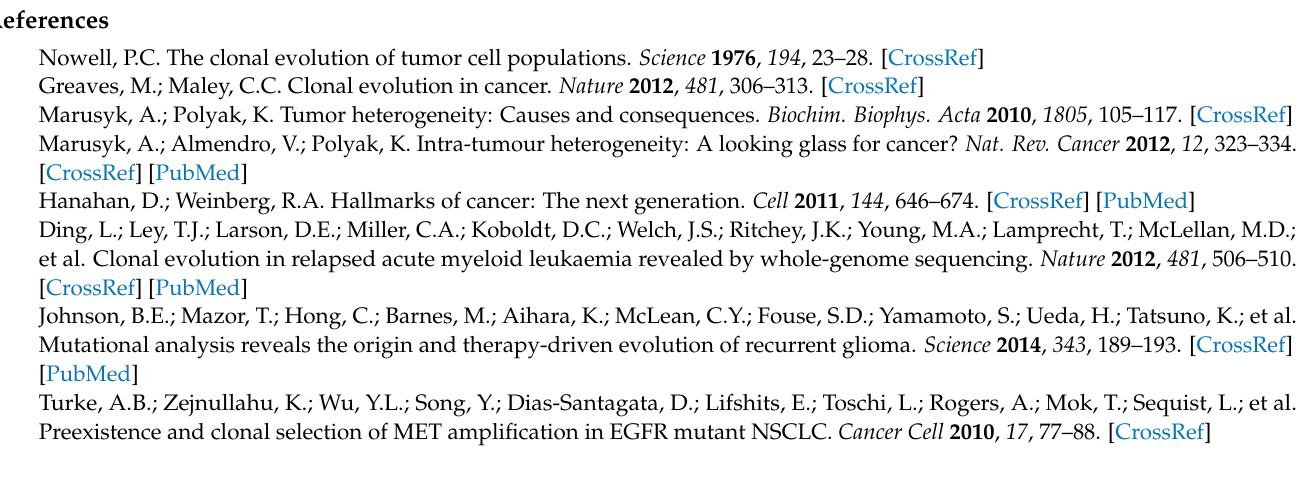
Figure S2: Average MALDI-ToF mass spectrum of the cancer ROI, Figure S3: Size of cancer ROI in tissue specimens analyzed by MALDI-MSI., Figure S4: Differences in heterogeneity of cancer ROI between the ND and PD groups of patients, Figure S5: Differences in heterogeneity of cancer ROI between patients’ groups, Figure S6: Tumor-Infiltrating Lymphocytes (TILs) in samples of breast cancer, Table S1: The intra-ROI similarity index for MSI spectra, Table S2: Significance of differences for the abundance of spectral components between clusters as well as between whole cancer ROIs of the ND and PD groups, Table S3: Peptides identified by LC-MALDI-MS/MS in breast cancers, Table S4: Proteins identified by LC-MALDI-MS/MS in breast cancers, Table S5: Hypothetical identity of MSI components based on their assignment to measured masses of tryptic peptides identified by LC-MS/MS, Supplementary